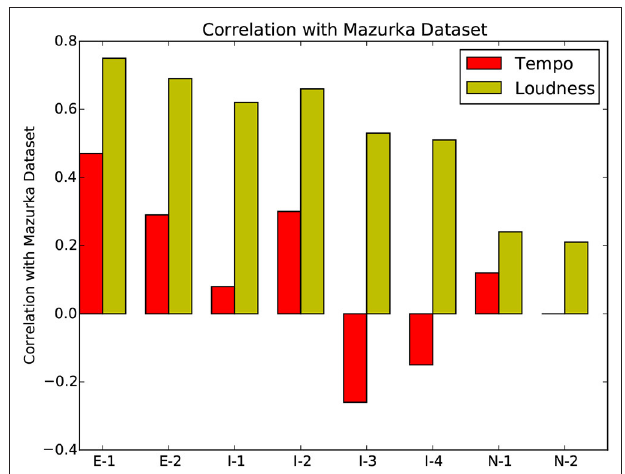
FIGURE 20 | Pearson product-moment correlation coefficient between the expressive features of each participant with the average Mazurka dataset.